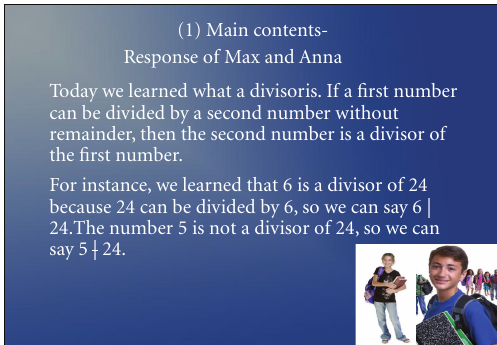
Figure 2: Screenshot of the introductory presentation: solved example problem for the organisation prompt (translated from